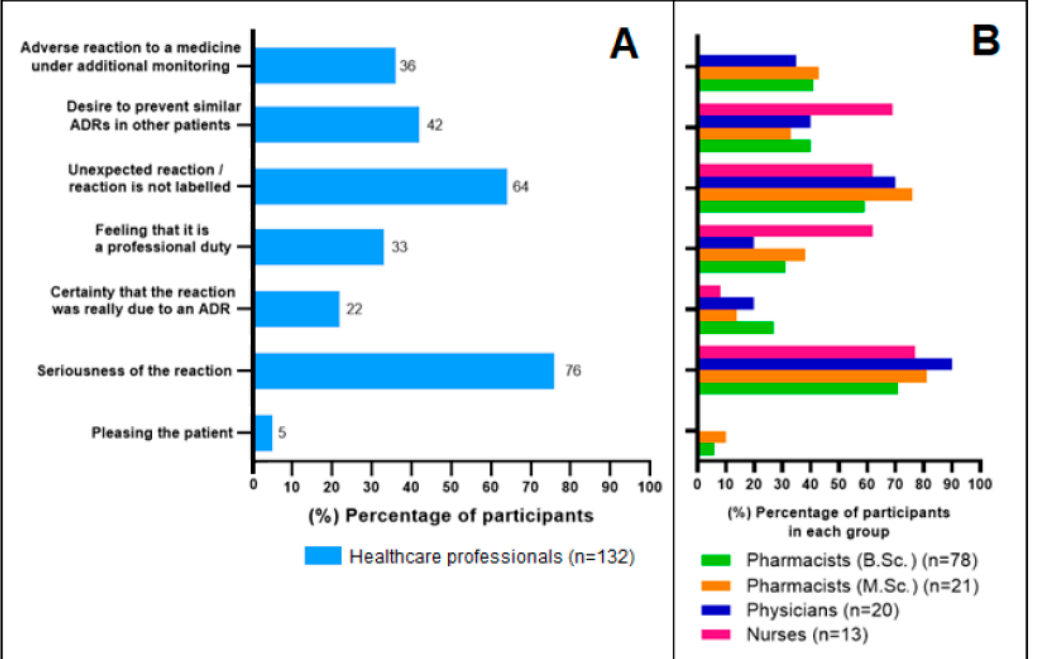
Figure 5. Healthcare professionals’ opinion as to what are the most motivating factors for them to report suspected adverse drug reactions (ADRs). ( A ): All responses, percentage (%) of HCPs selecting the answer option. ( B ): Percentage (%) of HCPs selecting the answer option in